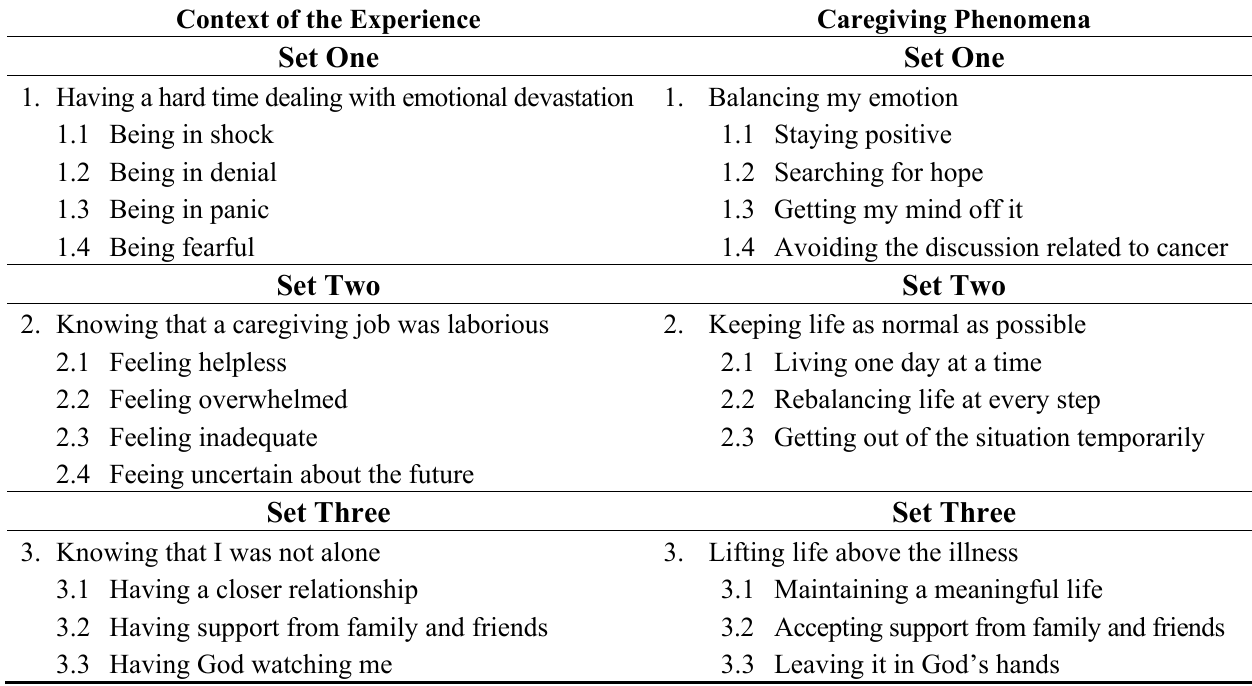
Table 1. The Context of the Experience and the Caregiving